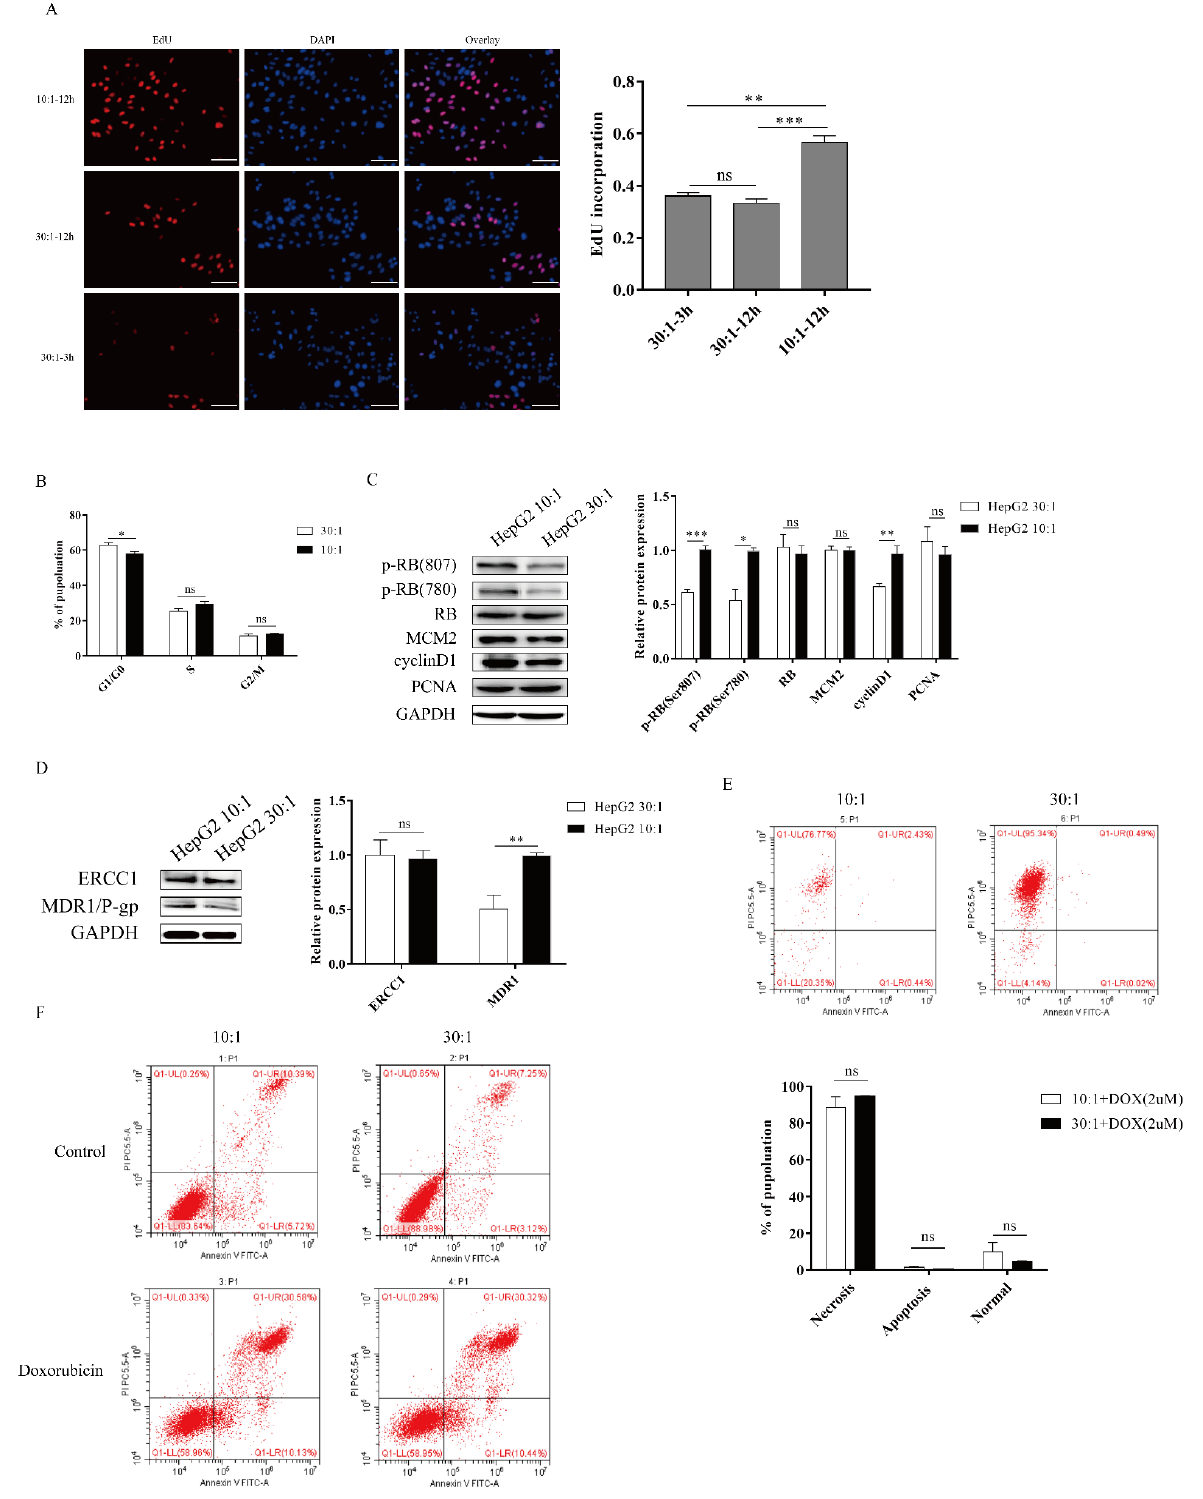
Figure 2. Higher substrate stiffness facilitates G1/S transition, proliferation, and resistance in HepG2 cells. ( A ) Detection of the cells proliferation after substrate stiffness treatment using EdU assay. HepG2 cells are cultured in 3D micropillars with different stiffness for 48 h before incubation with Edu. Quantification of positive cells undergoing DNA synthesis. (Scale bar: 100 µ m). ( B ) Detection of the cell cycle process by flow cytometry. HepG2 cells are cultured in 3D micropillars (10:1, 30:1) for 48 h. Flow cytometry analysis shows G1, G2/M, and S populations (n = 5). ( C ) Exploration of the cell cycle-related protein expression after substrates cues stimuli in HepG2 cells. HepG2 cells were cultured on 3D micropillars (10:1,